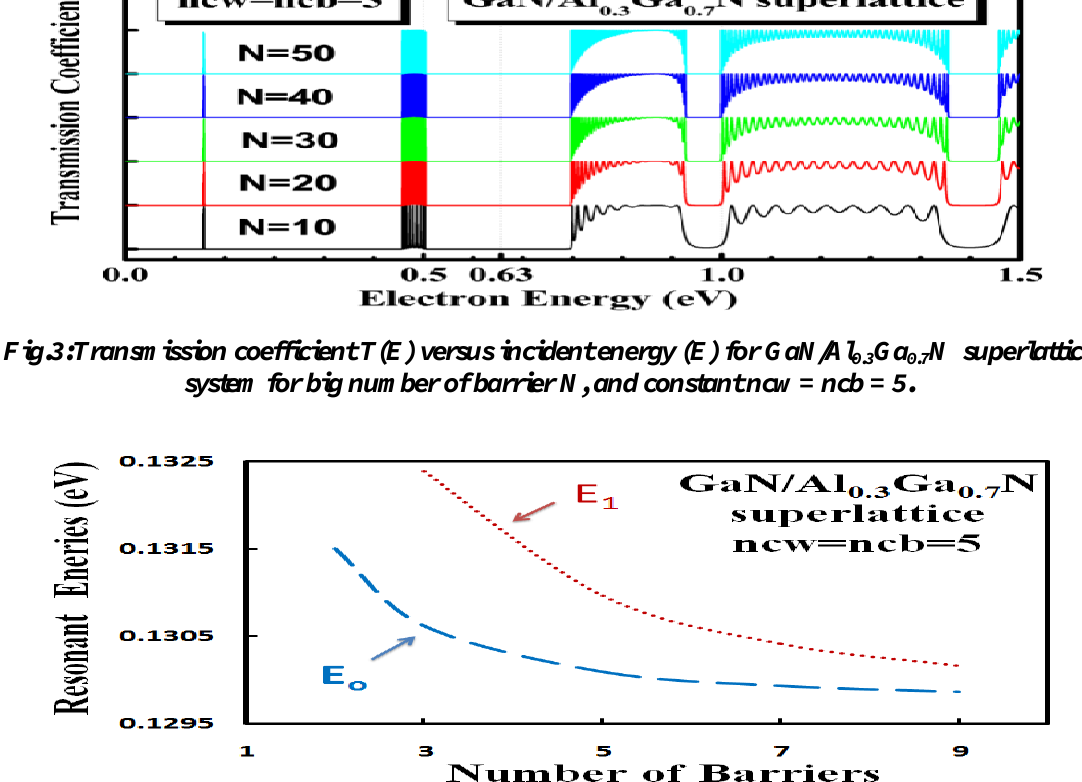
and first excited state E о number of